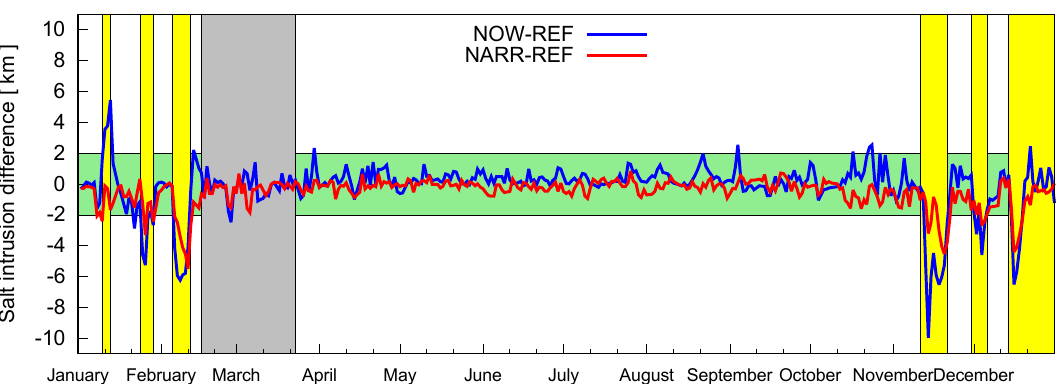
Figure 4. Time series of the difference in salinity intrusion length between the NOWIND (NOW − REF), NARR simulation (NARR − REF), and the REF model simulation. The green horizontal band represents the range between − 2 km and +2 km, while the yellow vertical bands and the grey area are as in Figure 3.